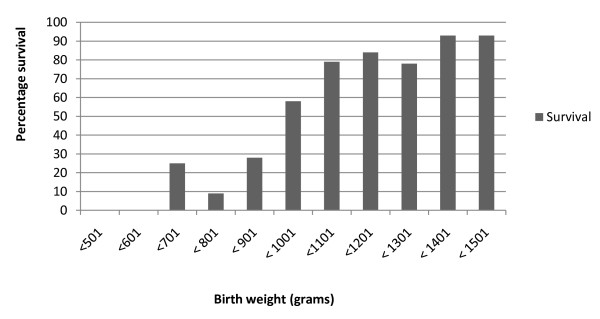
Survival by birthweight category.